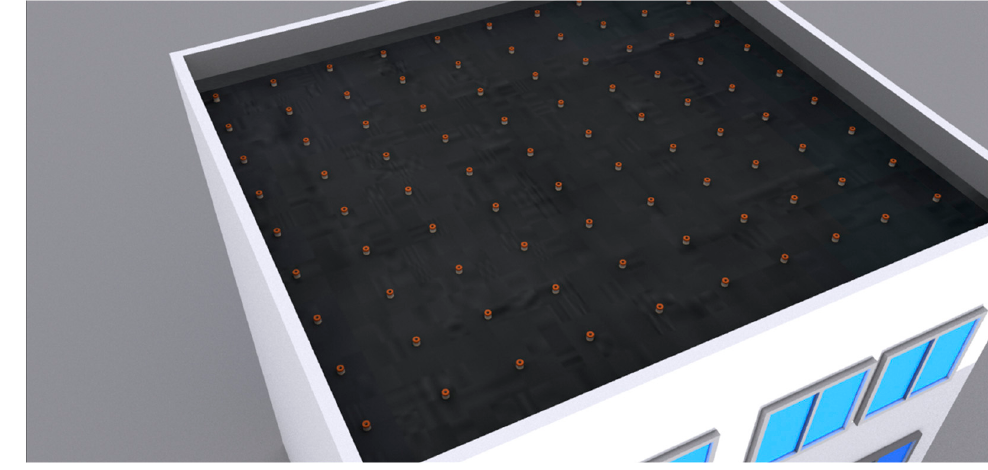
Figure 4. A 1 cm layer of polystyrene foam used to create a smooth surface for the upper layers.